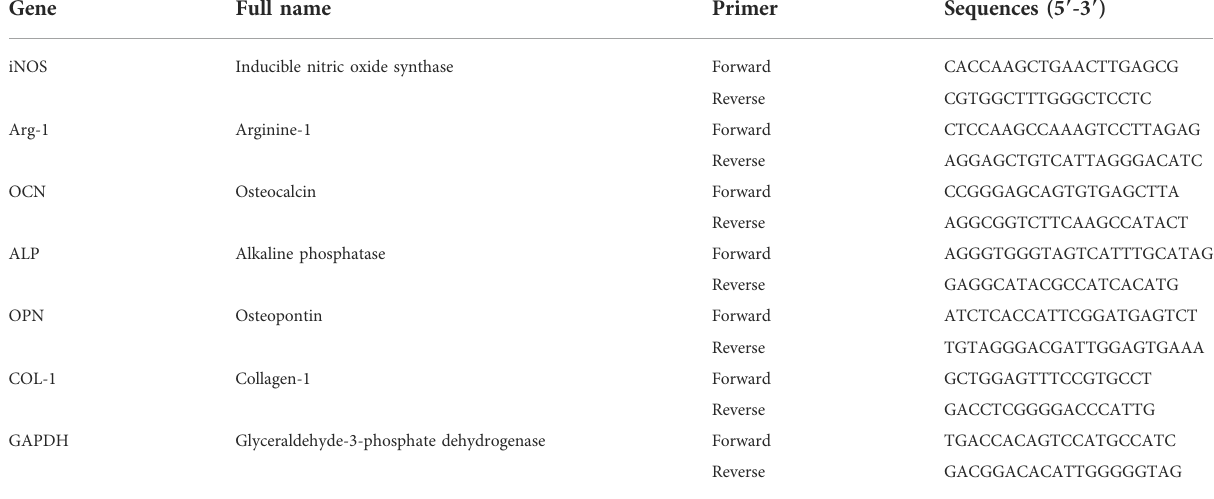
TABLE 1 Primer sequences used in the